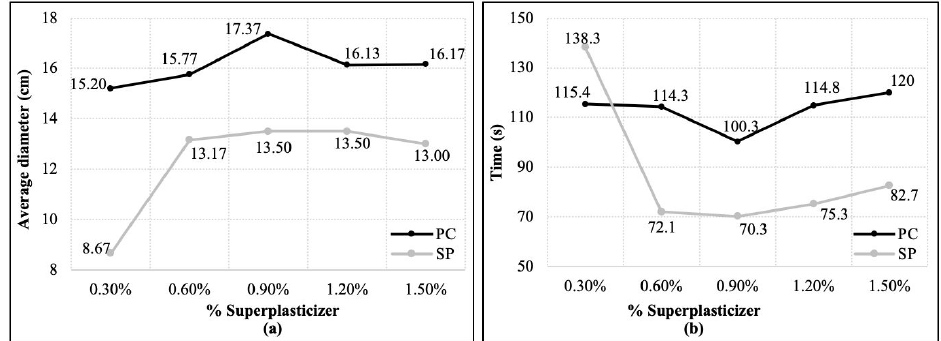
Figure 2. Saturation dosage test of the superplasticizer with PC and SF in the Kantro’s Miniature Slump Test 30 (a) and in the Marsh’s cone 31 (b). Table 4. Potential composition of PC. Element